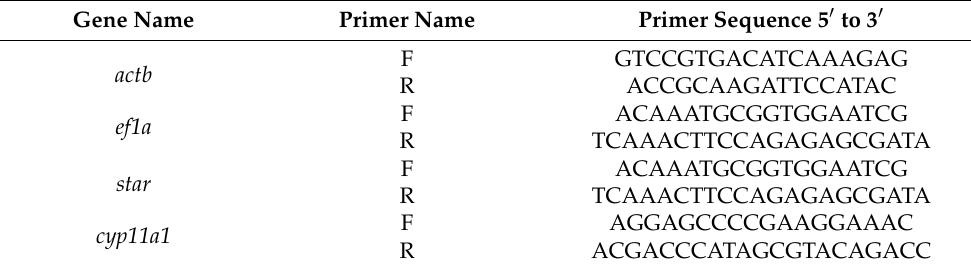
Table 2. Primers for